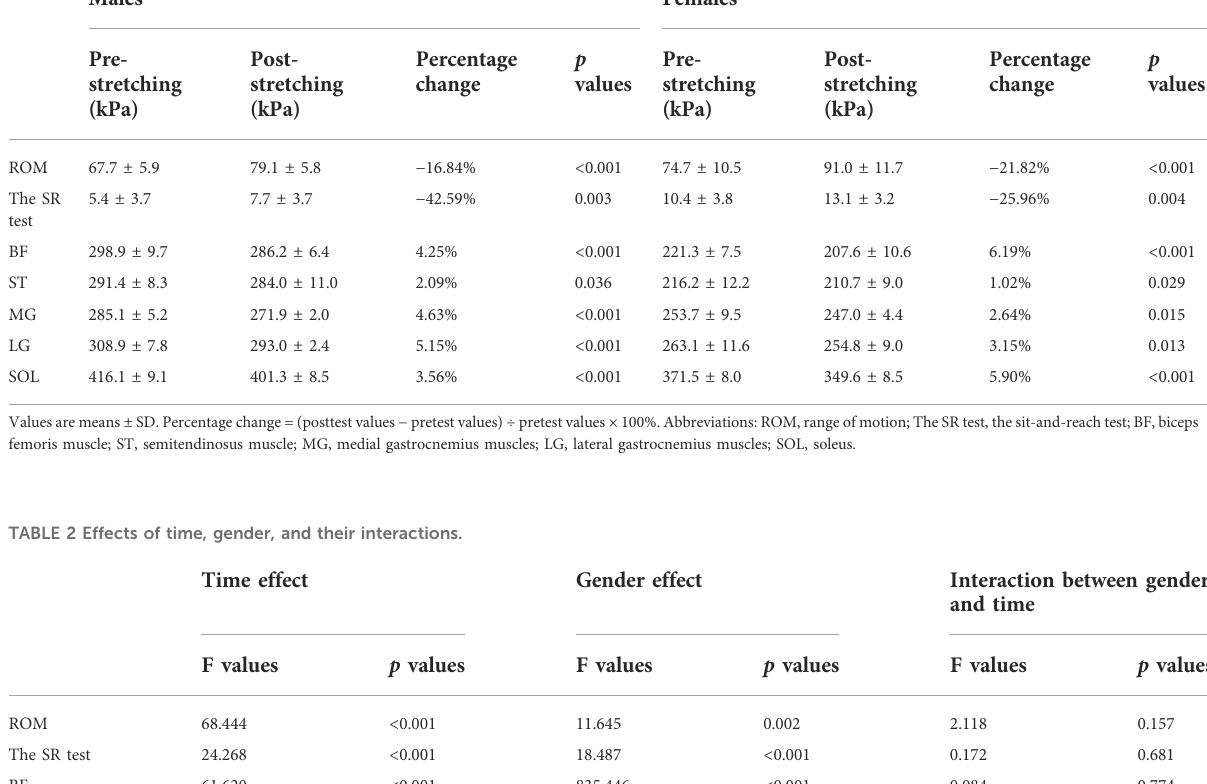
TABLE 1 Comparison of hamstring fl exibility and muscle stiffness between genders.